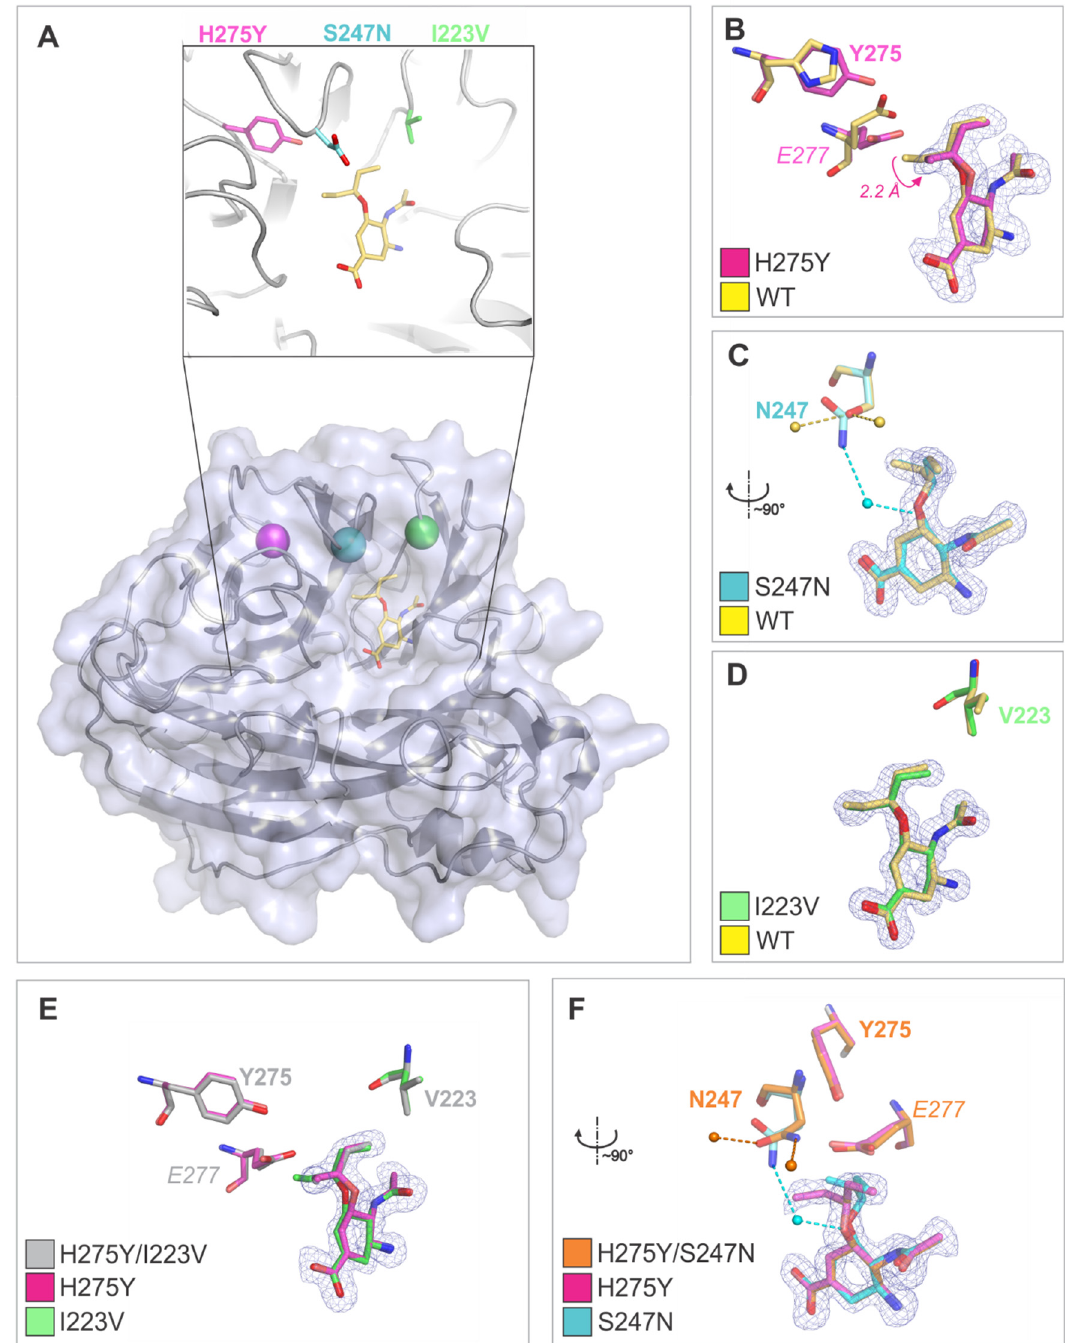
Figure 2. Crystal structures of mutant neuraminidase variants with oseltamivir. ( A ) Overall NA2009 structure with oseltamivir bound in the active site. Positions of the substituted amino acid residues are highlighted. Panels ( B – D ) show comparisons of the wild type enzyme active site with structures of enzymes carrying single amino acid substitutions. Panels ( E , F ) depict comparisons of the active sites of enzymes carrying single amino acid substitutions with variants containing two substitutions. The 2 F O - F C electron density map for oseltamivir is contoured at 1 σ . Substituted residues and residues with large structural changes are shown as sticks and labeled. Carbon atoms and water molecules of wt NA2009 are colored golden, H275Y magenta, I223V green, S247N turquoise, H275Y/I223V grey, and H275Y/S247N orange. Water molecules are represented by spheres with hydrogen bonds shown as dashed lines.